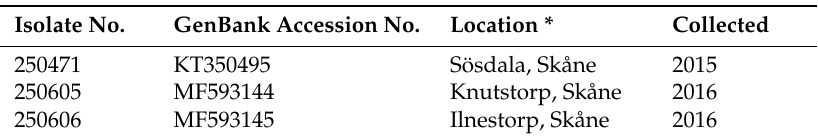
Table 1. Neonectria fuckeliana isolates from Norway spruce ( Picea abies ) used for inoculation studies of young Norway spruce plants. Isolate No. GenBank Accession No. Location * Collected